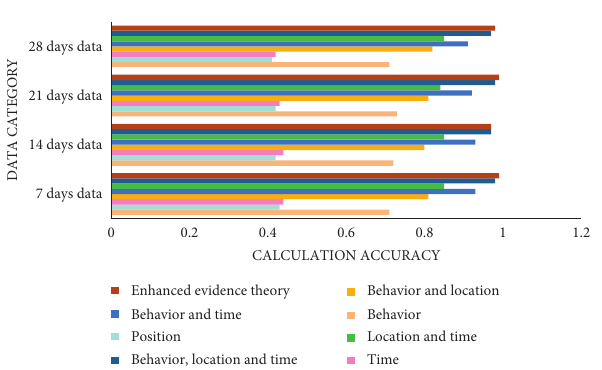
Figure 6: Calculation accuracy of evidence theory.